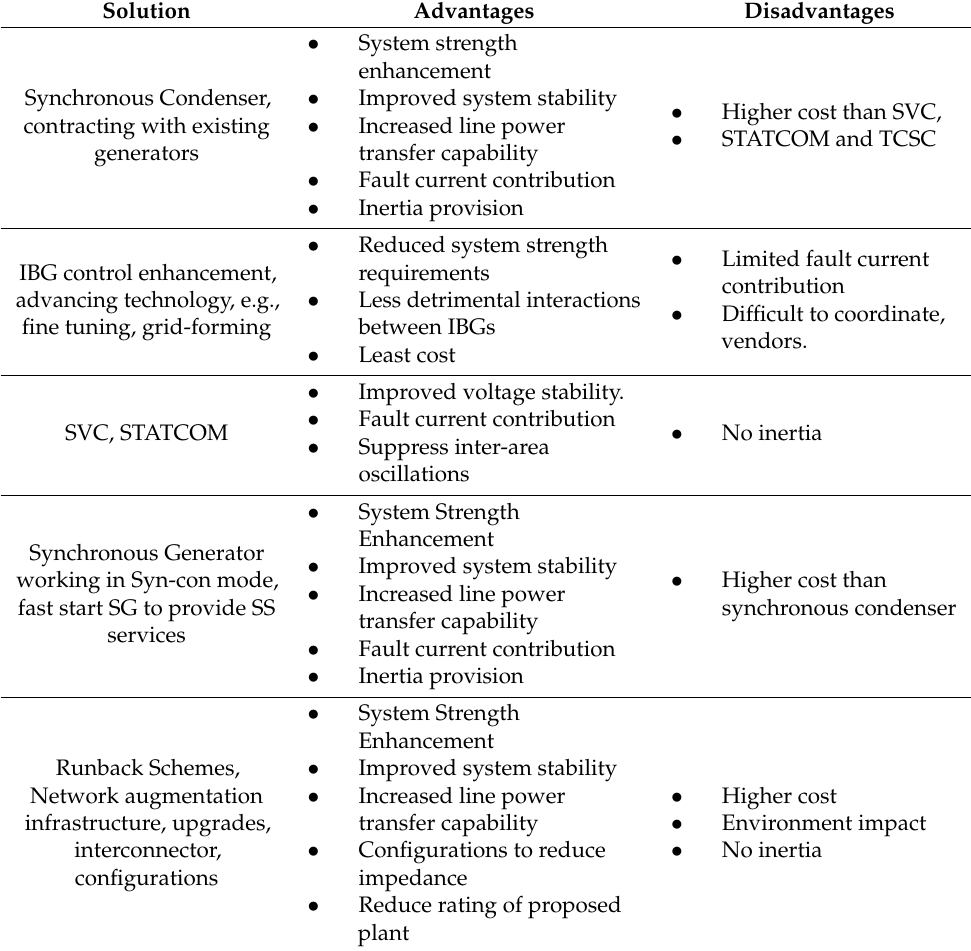
Table 5. Pros and Cons of Approaches to System Strength